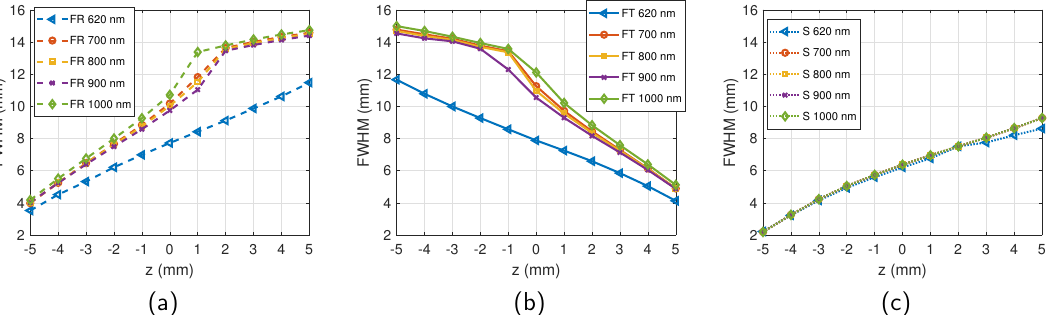
Figure 7. Spatial resolution for full-field illumination and scanning system as a function of z position. ( a ) FR: full-field illumination system reflection mode. ( b ) FT: full-field illumination system transmission mode. ( c ) S: scanning system. Optical properties are the same as those indicated by Figure 2. Separation between the two targets is D = 16mm. λ ex =